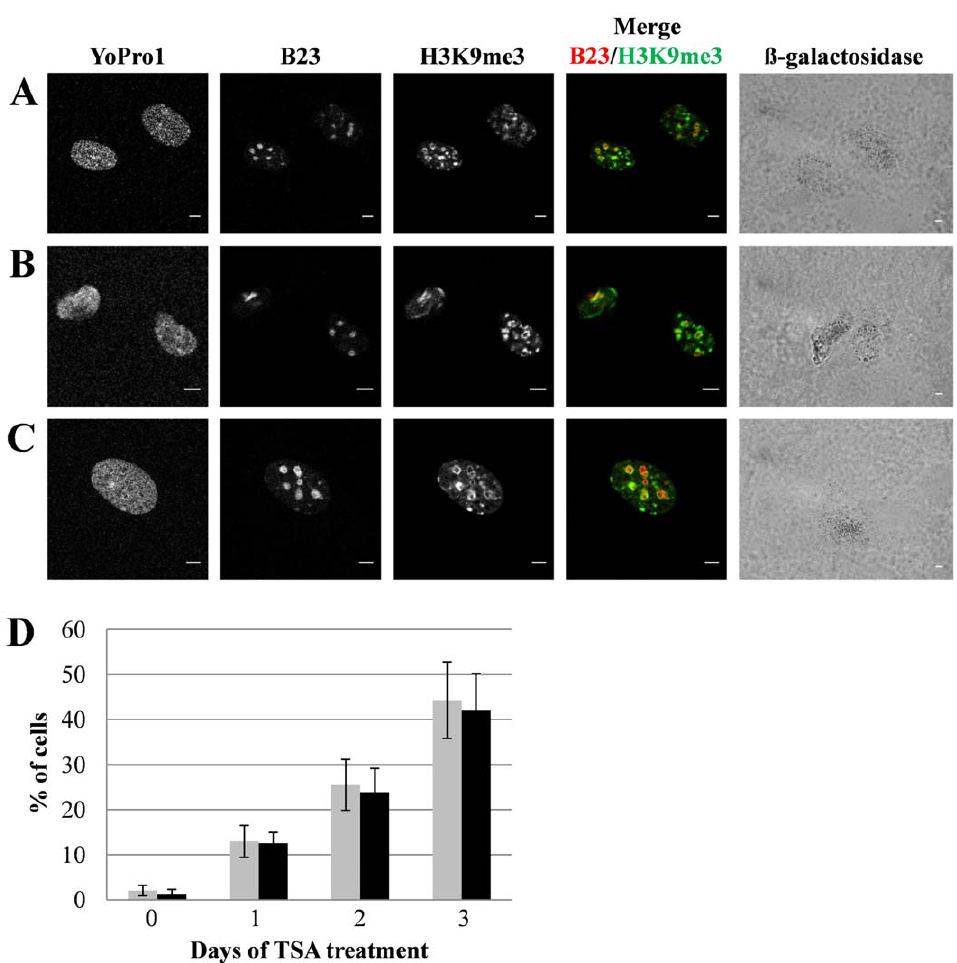
Figure 4. Induction of senescence and nuclear distribution of heterochromatin in primary bovine fibroblasts after treatment with trichostatin A (TSA). Young bovine fibroblasts at passages 2–3 were treated with 1 mM TSA for 1, 2, or 3 days ( A–C ) to induce senescence and then were stained for B23, H3K9me3 and beta-galactosidase. Note that the H3K9me3 (green) pattern has a high intensity and is distributed around nucleoli (B23; red). Scale bars: 5 m m. ( D ) The percentage of beta-galactosidase-positive cells (gray bars) and cells with the ring-like chromatin distribution (black bars) was counted at 0, 1, 2 and 3 day of TSA treatment (n=200 for beta-galactosidase staining and n=80 for immunofluorescence for each experimental point; the results of two independent experiments are